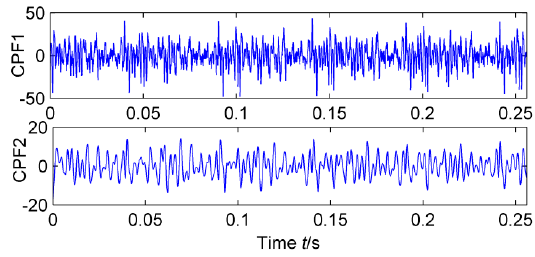
Figure 22. CPF of vibration signal of faulty gearbox.